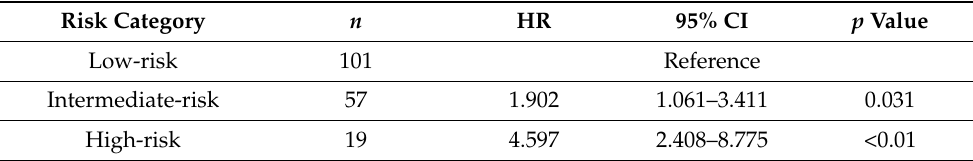
Table 4. Hazard ratio for each risk